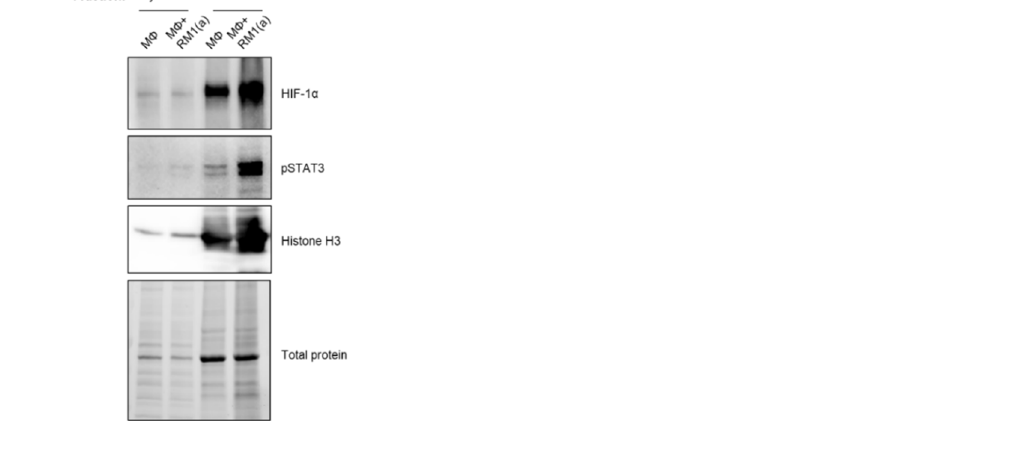
Figure A4. Cytosolic and nuclear fractions from efferocytic BM macrophages. BM macrophages (M Φ ) were isolated from 4 wk old C57BL/6J mice and co-cultured with apoptotic RM1(a) cells for 16–18 h ( n = 1, Experiment 2). Cytosolic and nuclear fractions from efferocytic (M Φ + RM1(a)) and non-efferocytic (M Φ ) BM macrophages were analyzed by Western blotting using HIF-1 α , p-STAT3, and Histone H3 antibodies.